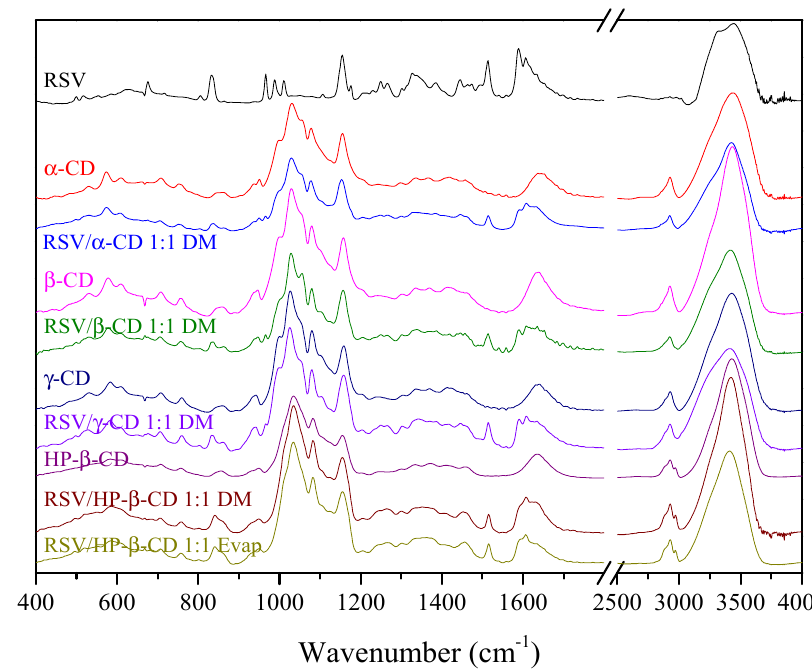
Figure 2. FT-IR spectra of selected powder resveratrol (RSV)/cyclodextrin (CD) systems. 383 Above 800 cm − 1 , the RSV/CD systems show bands derived from RSV (833 cm − 1 , C-H outside of the plane). In the range of 1200–1300 cm − 1 , two RSV bands are